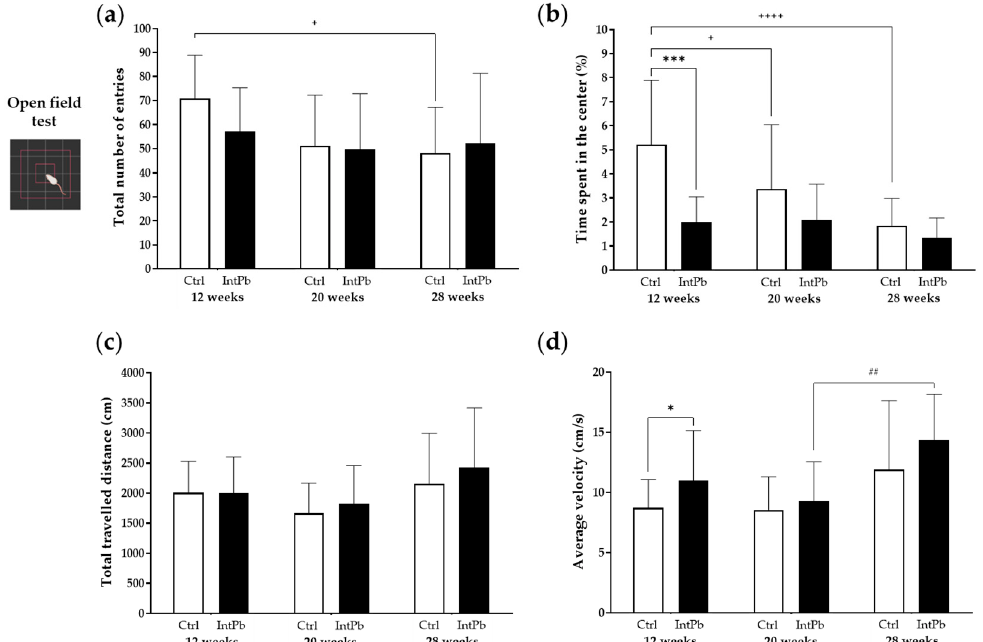
Figure 1. Locomotor and exploratory behaviors and anxiety-like behavior assessed by the open-field test: ( a ) Total number of entries in the different regions. ( b ) Time spent in the central zone. ( c ) Total travelled distance in the apparatus. ( d ) Average velocity of the animals in the apparatus. Values are expressed as the mean ± SD for n IntPb = 15 and n Ctrl = 18 for each evaluated time-point. Symbols denote statistically significant differences inter (Ctrl vs. IntPb—* p < 0.05; *** p < 0.001) and intra groups (Ctrl 12w vs. Ctrl 20w vs. 28w—+ p < 0.05, ++++ p < 0.0001; IntPb 12w vs. IntPb 20w vs. 28w—